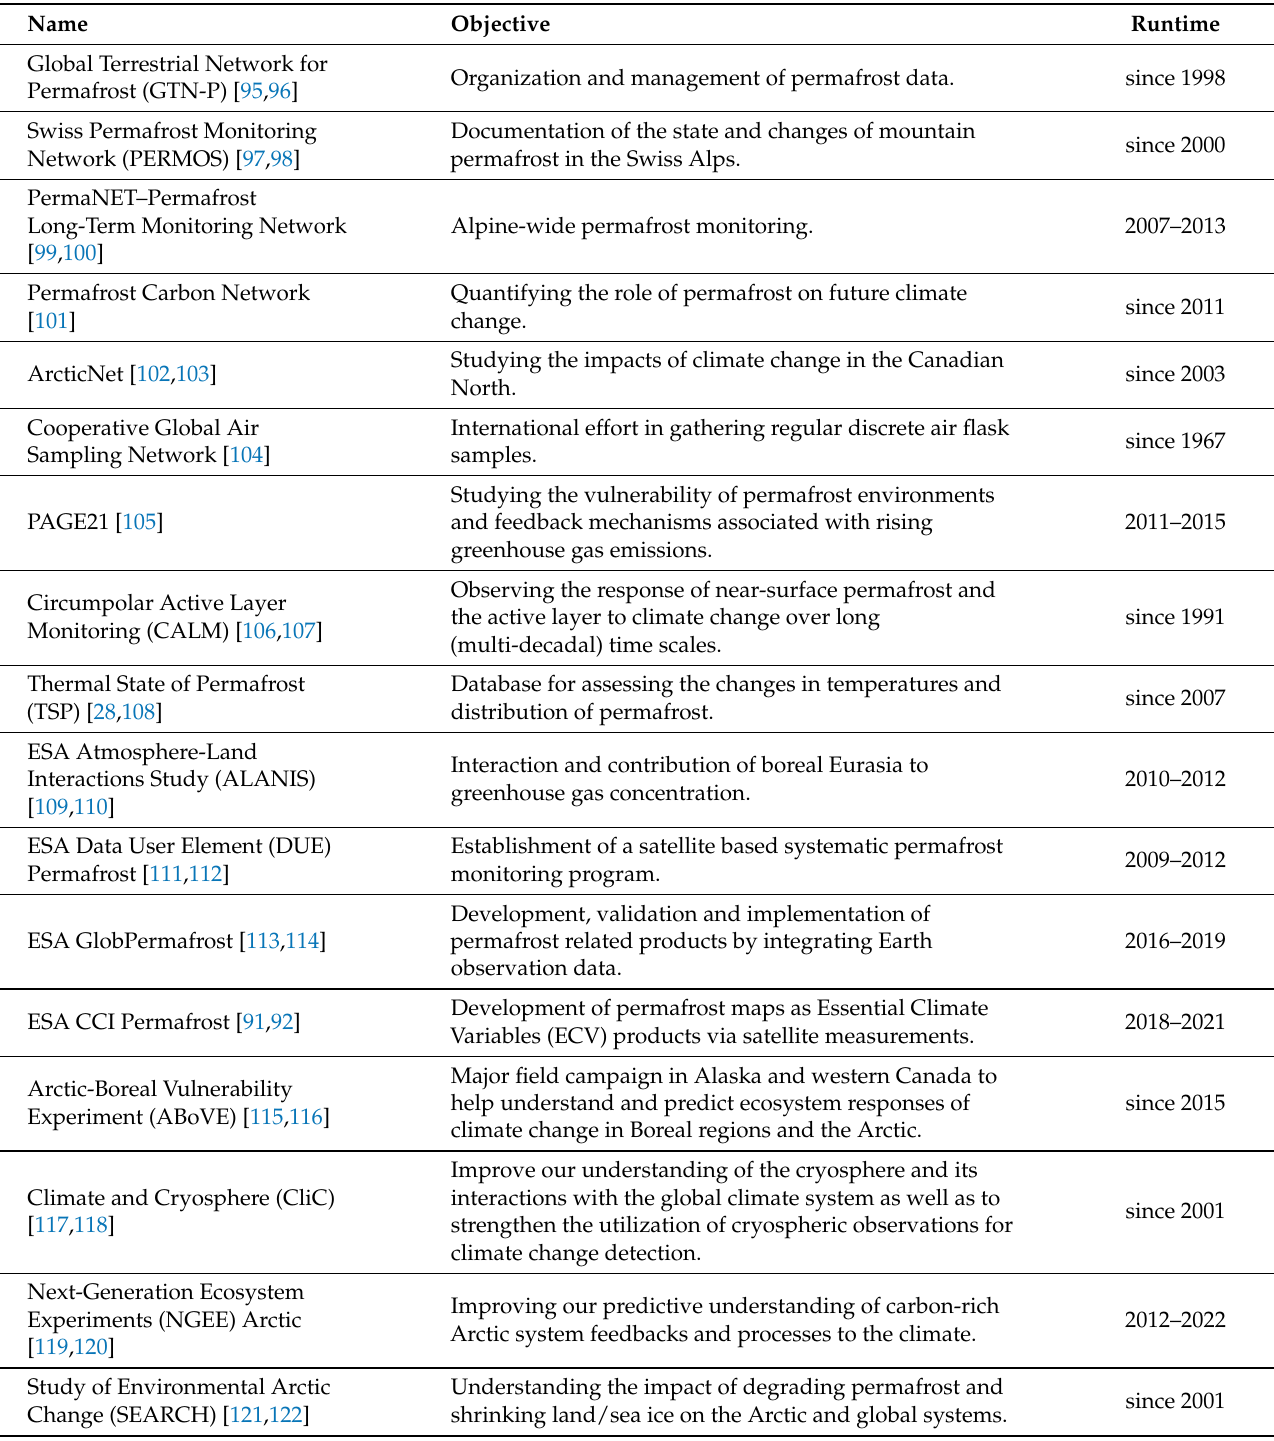
Table 1. A variety of recent and ongoing permafrost related programs and